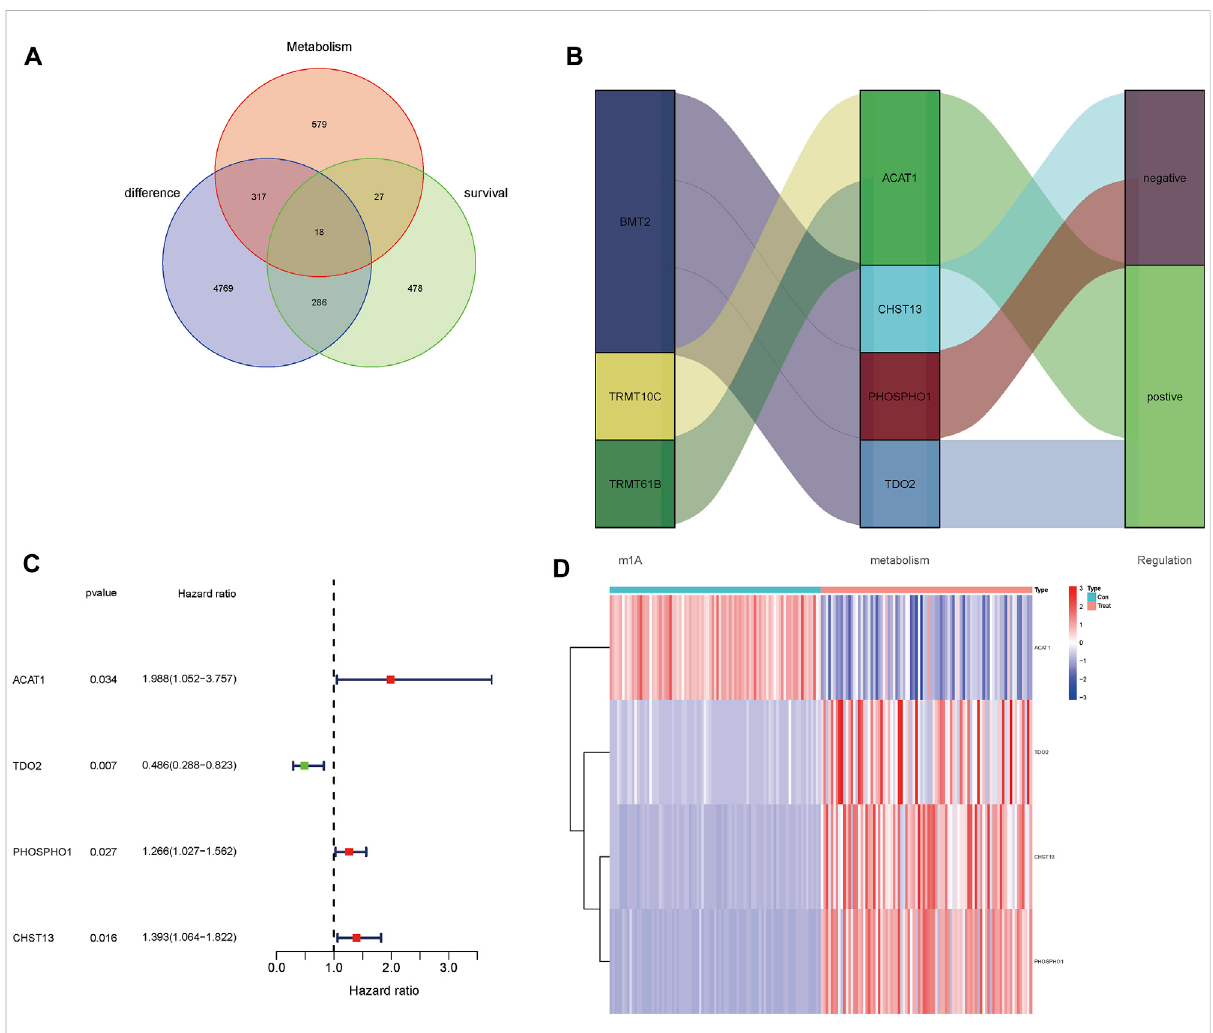
Identi fi cation of m 1 A methylation-related metabolic genes. (A) The intersection among clusters metabolism-related genes, survival-related genes, and differentially expressed genes. (B) The Sankey diagram of m 1 A methylation-related genes and metabolism-related genes. (C) The forest plot of four MRmetabolism was plotted by univariate Cox regression analysis. (D) The heatmap of differential expressions of four